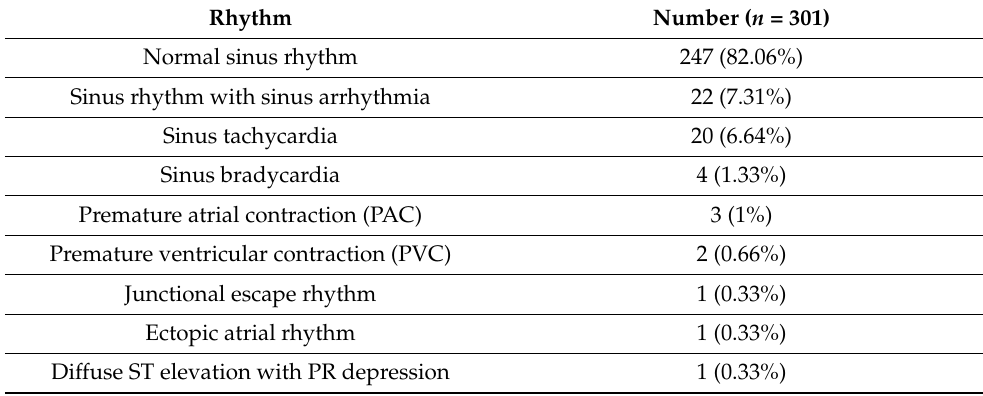
Table 4. Electrocardiographic findings after second vaccine dose.